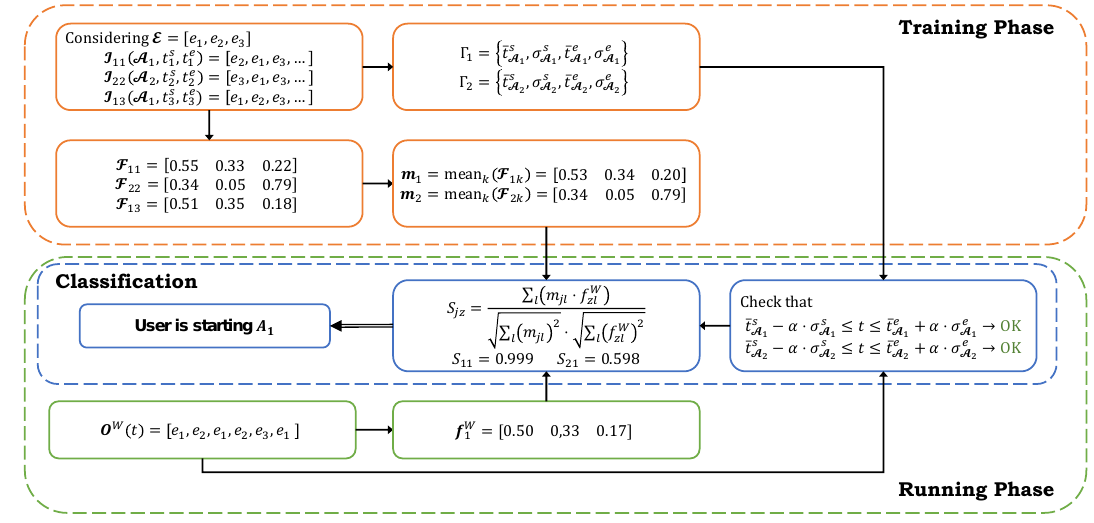
Figure 3. Flowchart of the steps for the activity recognition